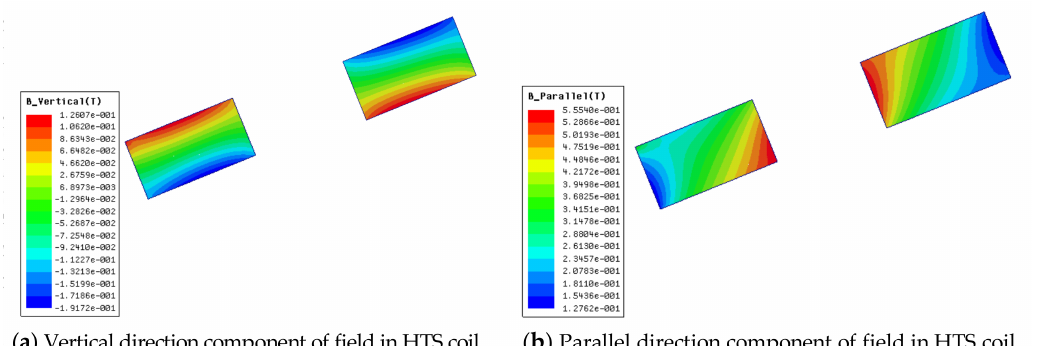
Figure 8. Flux density distribution of a HTS coil on basic model.